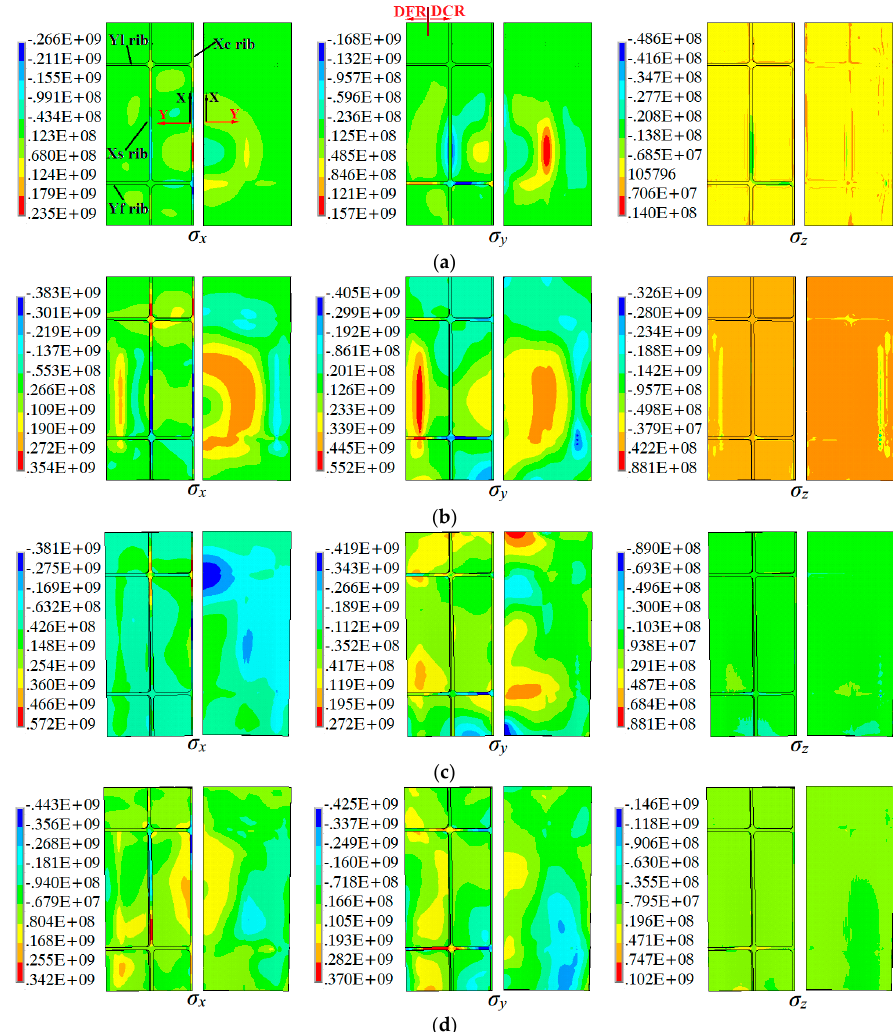
Figure 8. Normal stress components (Pa) of GP in position A: ( a ) at t = 51 μ s; ( b ) at t = 139 μ s; ( c ) at t = 394 μ s; and ( d ) at t = 612 μ s. t = 394 µ s; and ( d ) at t = 612 µ s.